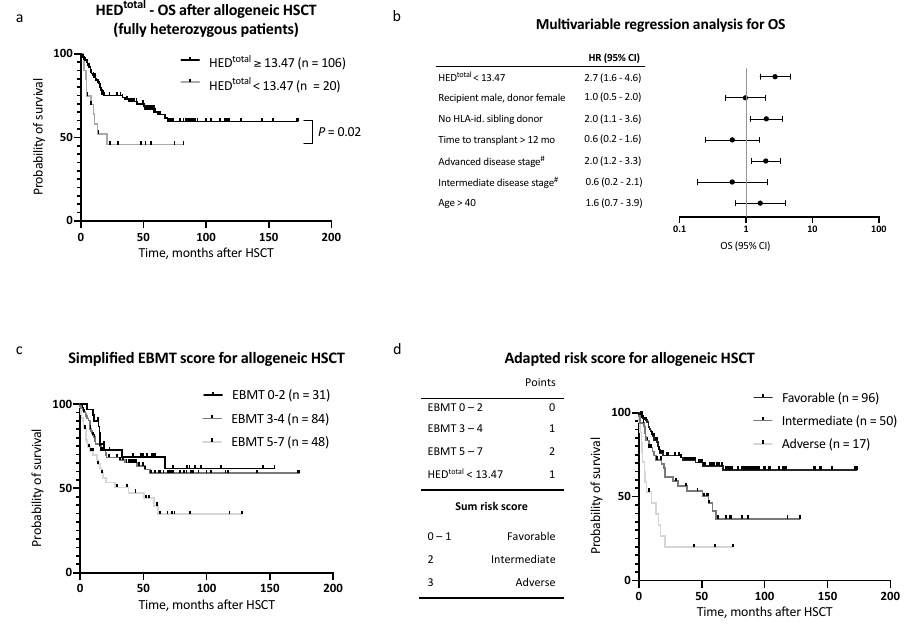
Figure 2. Overall survival multivariable regression analysis and risk score assessment. ( a ) Kaplan–Meier analysis of OS with regard to HED total , considering only patients fully heterozygous for HLA-A, HLA-B, HLA-C, and HLA-DR ( n = 126). ( b ) Multivariable Cox regression analysis of the impact of low HED total on OS. ( c ) Kaplan–Meier analysis of OS with regard to European Society for Blood and Marrow Transplantation (EBMT) risk score [11] in a simplified adaption into three risk categories. Respective clinical data for risk score calculation was available for 163 patients. ( d ) Left panel: Inclusion of the risk factor low HED total to the EBMT risk score [11], yielding three major risk categories. Right panel: Kaplan–Meier analysis of OS in the AML patient cohort ( n = 163) with regard to the adapted risk score. Abbreviations: HED indicates HLA evolutionary divergence; OS, overall survival; HSCT, hematopoietic stem cell transplantation; HLA-id., HLA-identical; mo, months; EBMT risk score, European Society for Blood and Marrow Transplantation risk score [11]; and # , versus early